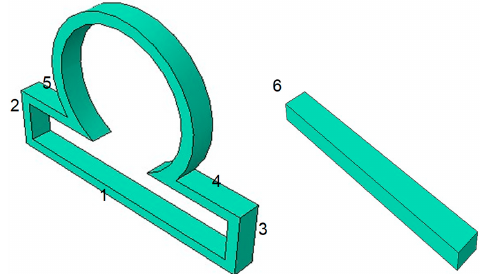
Figure 2. The computational geometric domain is partitioned into 6 subdomains to apply boundary conditions in each of the subdomains.